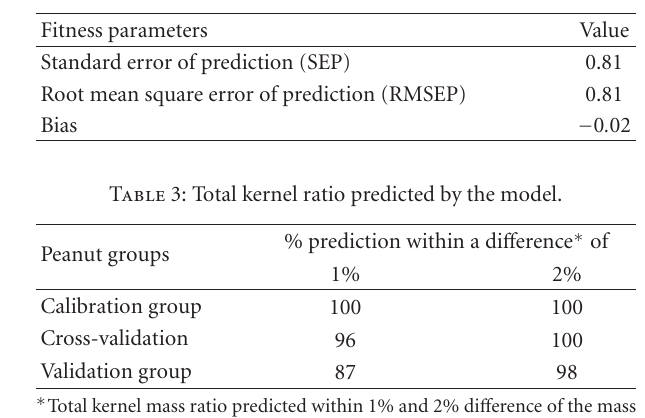
Table 2: Fitness measures of MLR model on validation group of in-shell peanuts.